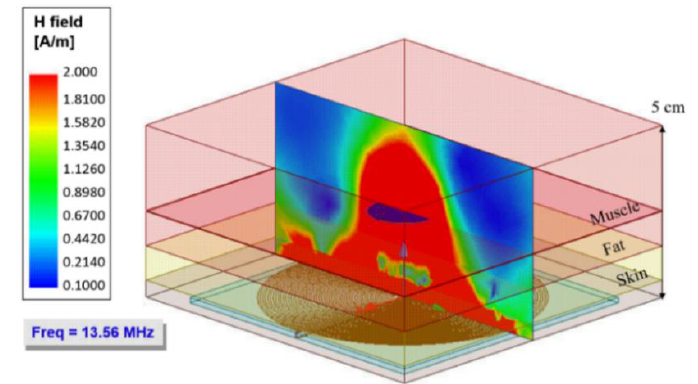
Figure 9. The intensity of the magnetic flux for the inductive power transfer (IPT) system at 13.56 MHz. The bottom plane represents the external coil (radiating source).